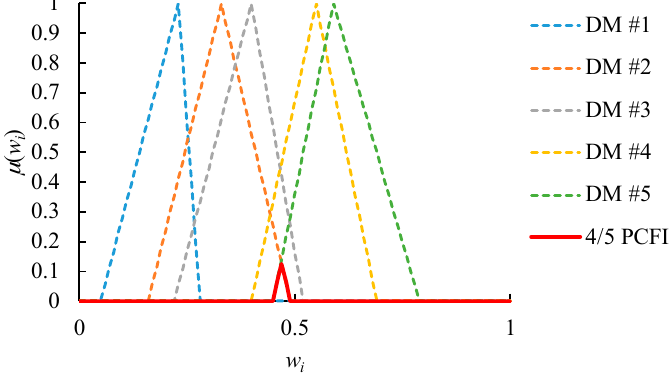
Figure 4. The 4 / 5 partial consensus fuzzy intersection (PCFI) result. Figure 4. The 4/5 partial consensus fuzzy intersection (PCFI) result.